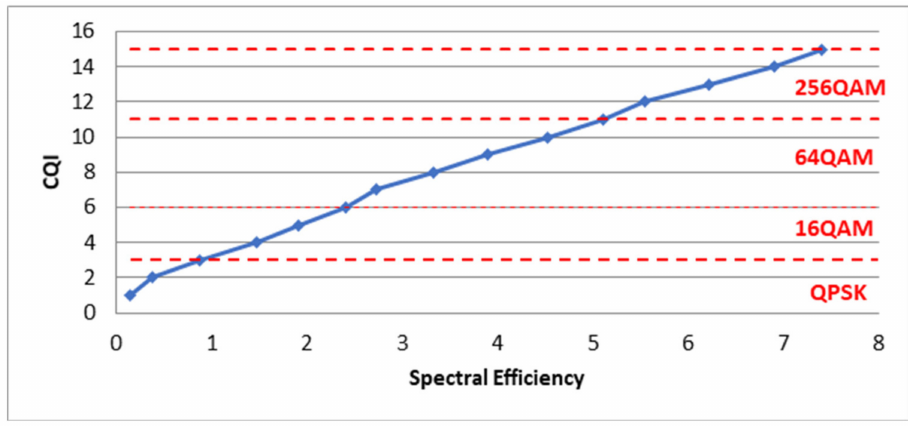
Figure 1. CQI vs. Spectral